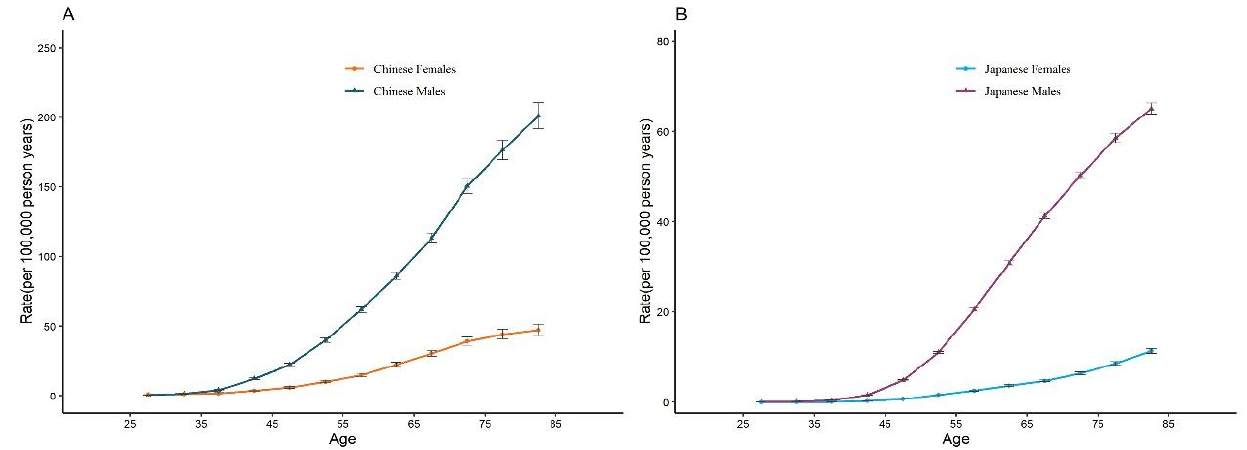
Figure 5. Longitudinal age curves of esophageal cancer mortality by genders in China ( A ) and Japan ( B ). Fitted longitudinal age-specific rates of esophageal cancer mortality rates (per 100,000 person- years) and the corresponding 95% CI. Table 3. The relative risks due to age, period, and cohort effects in China and Japan.